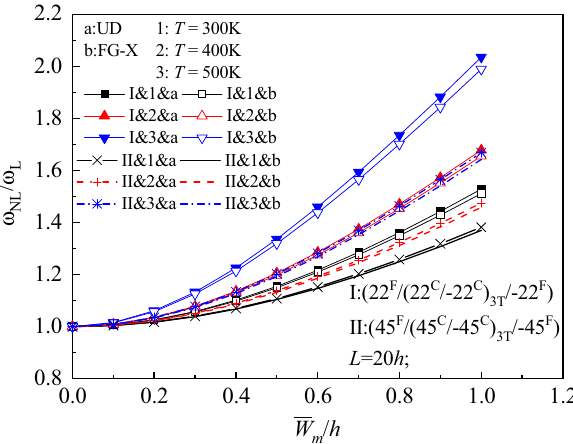
Figure 9: E ff ect of T on nonlinear vibration for hybrid plates.